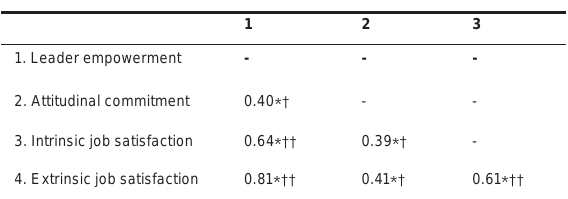
TABLE 3 Correlation coefficients between the LEBQ, MSQ and